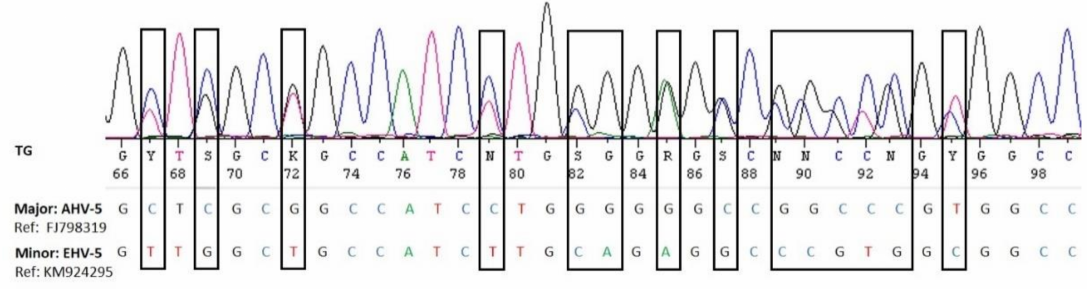
Figure 4. Visualization of the superimposed electropherograms of AHV-5 (major sequence) and EHV-5 (minor sequence) in sample LS030-2 (Table